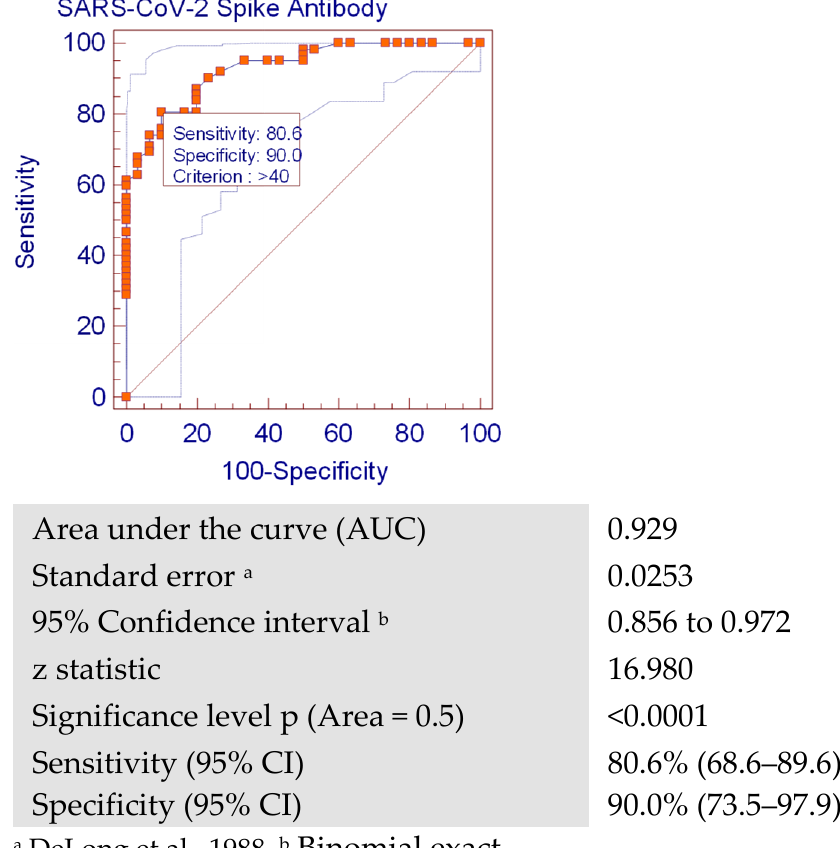
Figure 2. Receiver operating characteristic (ROC) curve analysis showing the cutoff value for SARS- CoV-2 anti-S predictive for positivity of neutralizing antibodies (with a sensitivity of 80.6% (68.6–89.6) and specificity of 90.0% (73.5–97.9)). Only 70.5% of anti-S-positive participants were also positive for nAbs, with a signif- icant difference ( p = 0.003) between the results of the anti-S and nAbs results (Table 2). Participants with positive results for both antibodies had a mean positive anti-S titer of 62.1 RU/mL, while a lower mean titer of anti-S (18.6 RU/mL) was recorded among participants with positive anti-S and negative